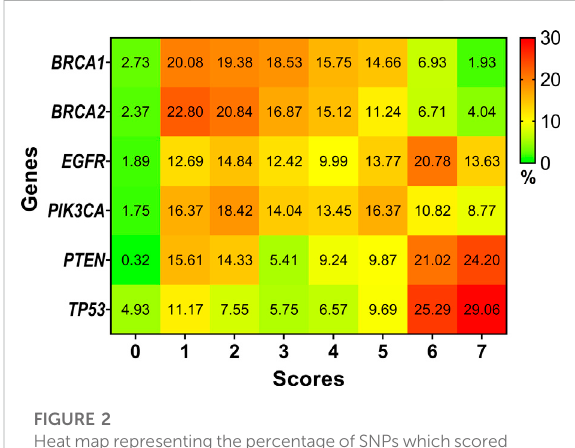
FIGURE 2 Heatmaprepresentingthepercentage ofSNPs which scored anywhere between a possible score of zero through seven based on our framework.